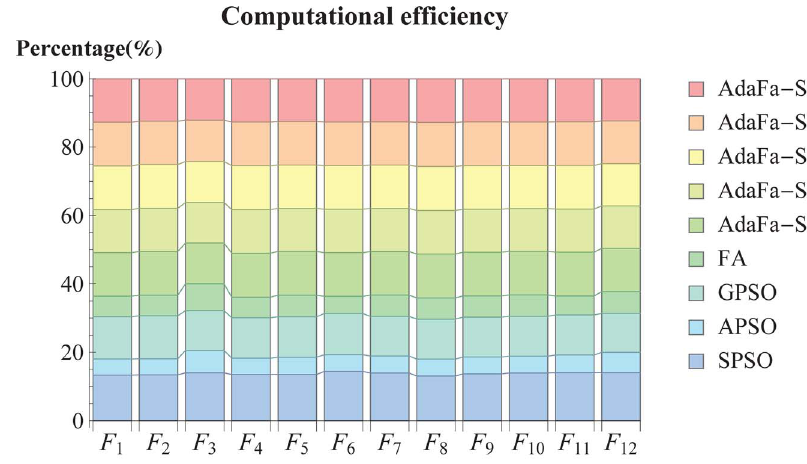
Figure 8. The comparison of computational efficiency of each algorithm on the test functions.